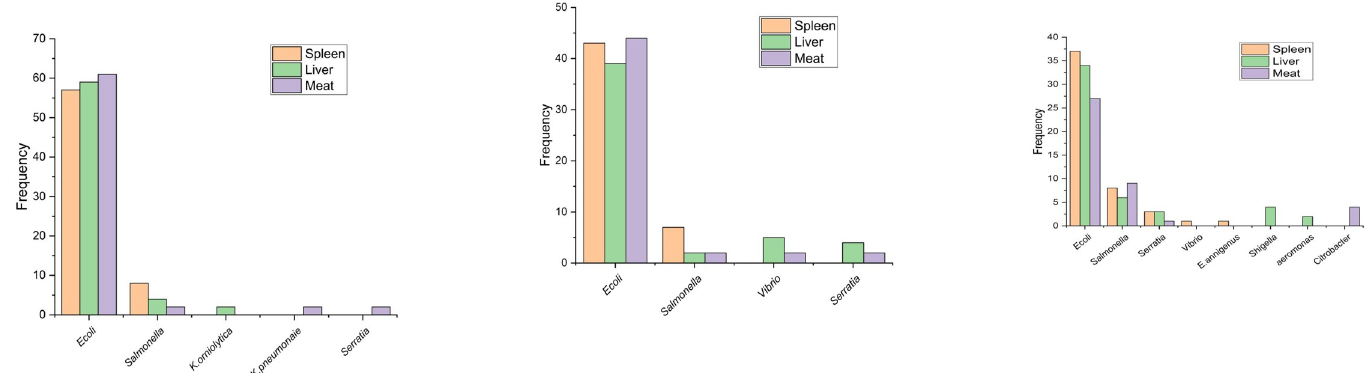
Fig 2. A. Different bacterial isolates from district Mardan. B. Different bacterial isolates from district Swabi. C. Different bacterial isolates from district Swat.